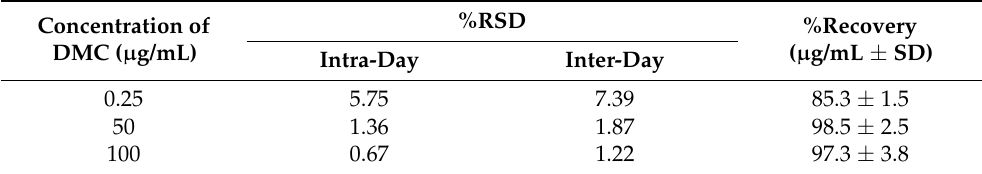
Table 1. Analytical of intra-day and inter-day precision assay and analytical recovery of DMC standard solution were added to